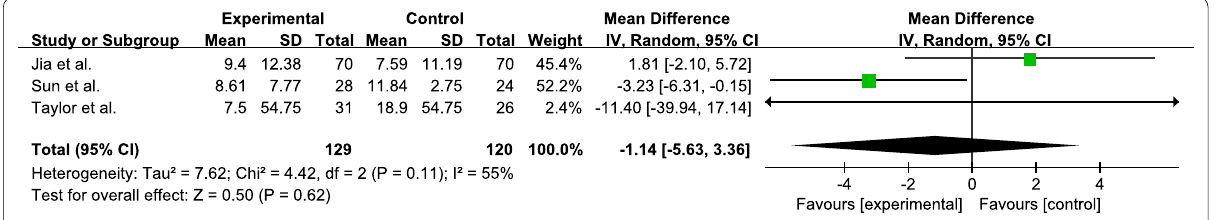
Fig. 4 Forest plot of the CRP by day 7–10 between the experimental group and the control group